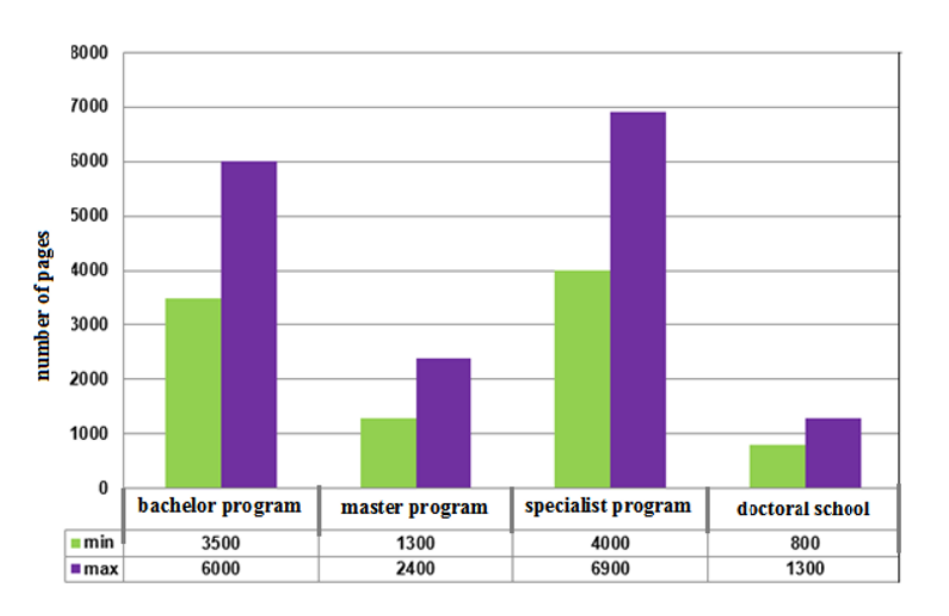
Fig. 3. MEP volume by higher education level.